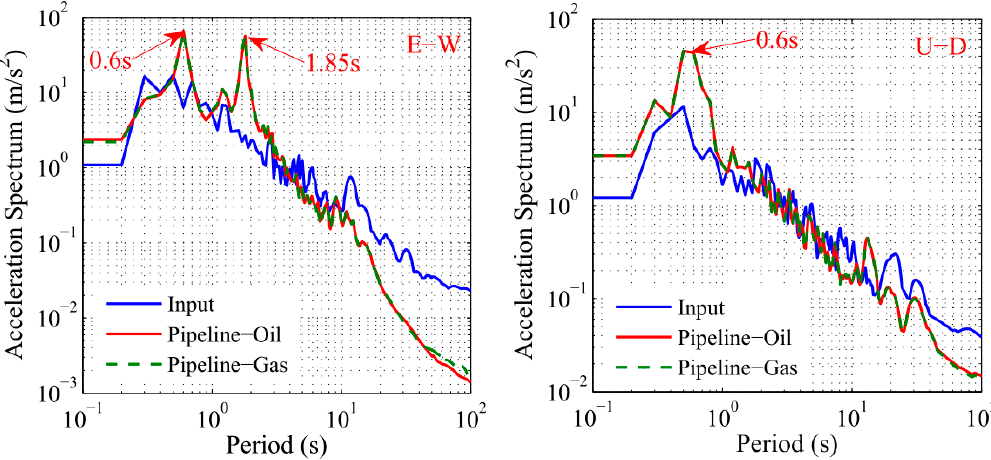
Figure 12. Acceleration spectrum of pipeline-gas system responding to input seismic wave.